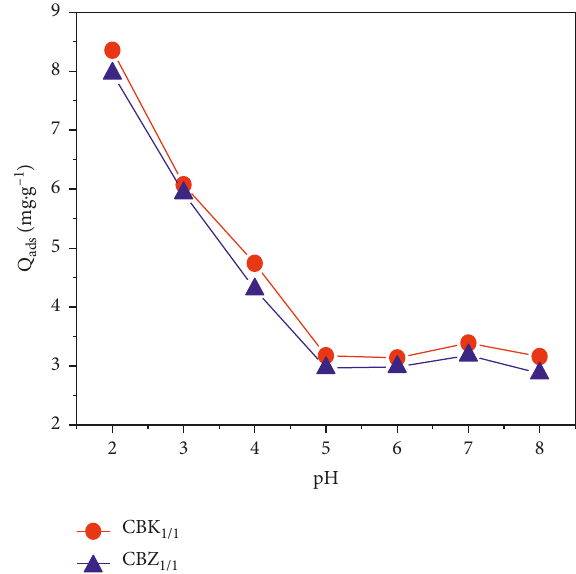
Figure 7: Effect of pH solution on the adsorption of indigo car- mine. Experimental conditions: C 0 � 50mg · L − 1 ; m � 100mg; V � 20mL; t � 80min; speed � 200rpm at room temperature.